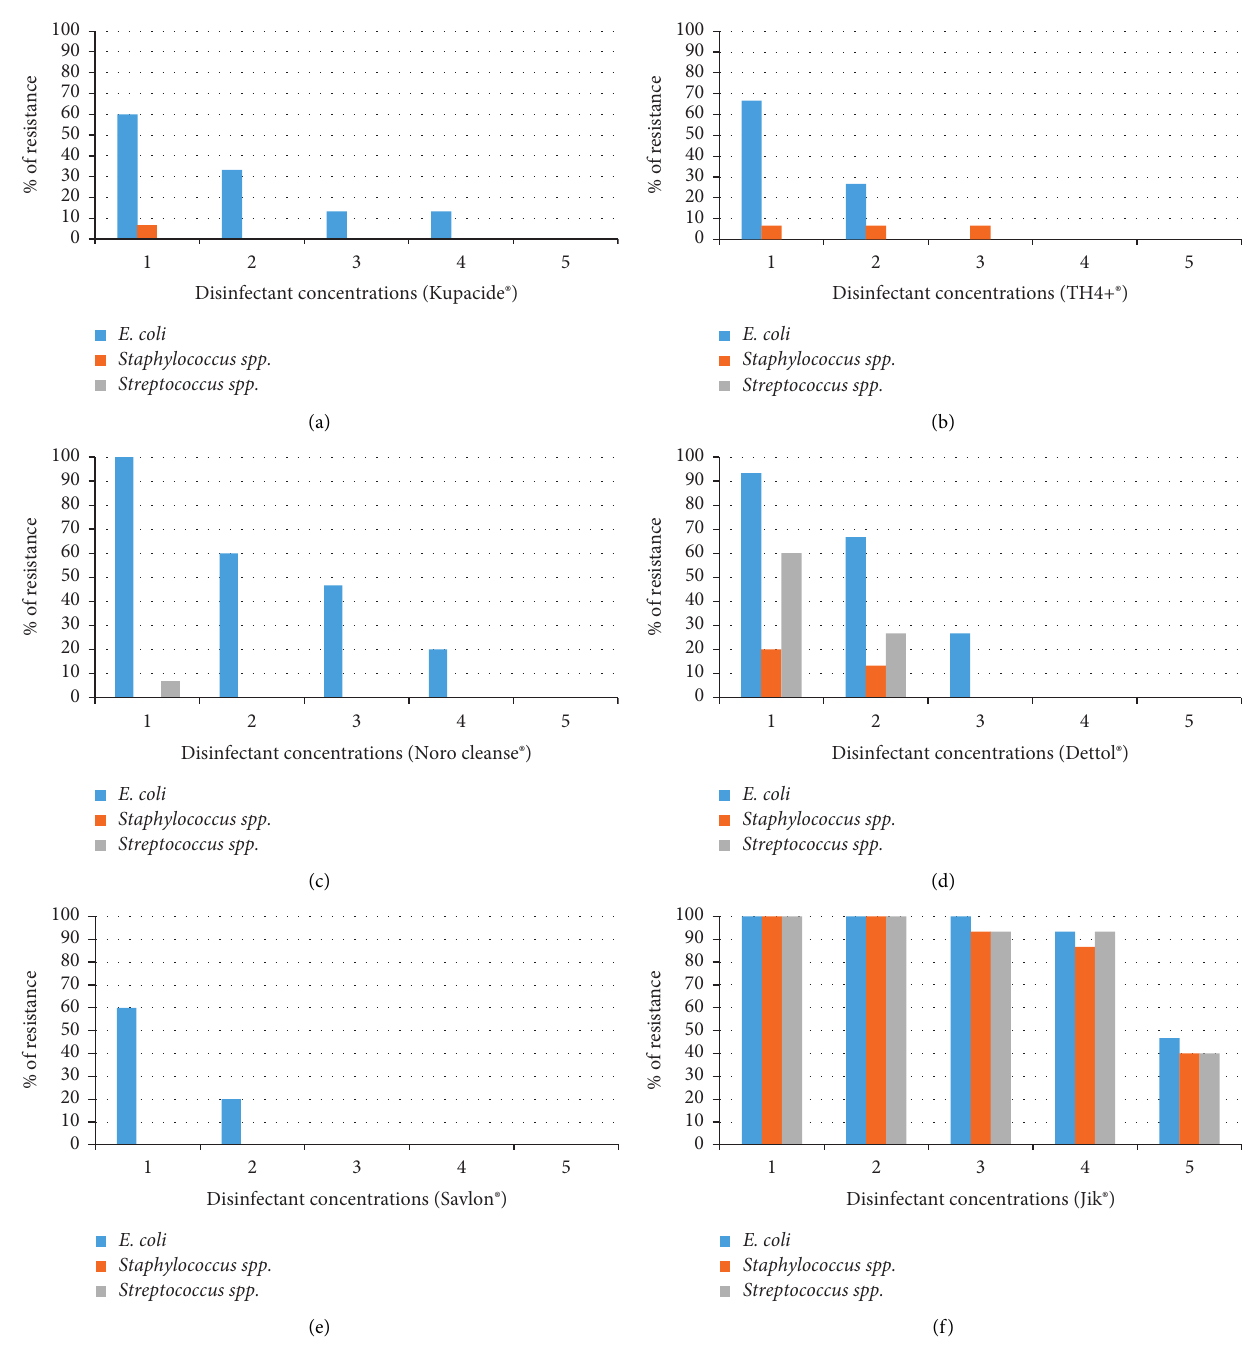
Figure 1: Resistance of isolates to the tested